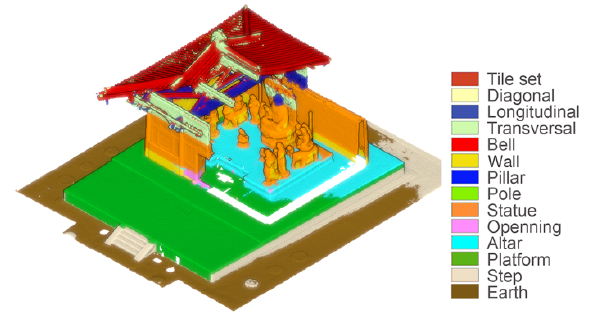
Figure 11. DT classification results for the great hall of NCS in